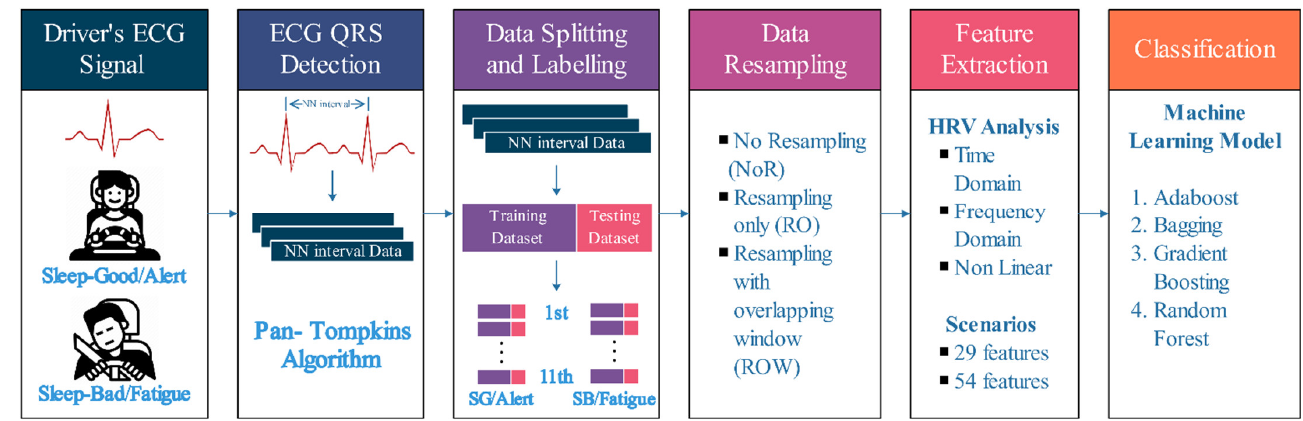
Figure 1. The proposed fatigue driving detection